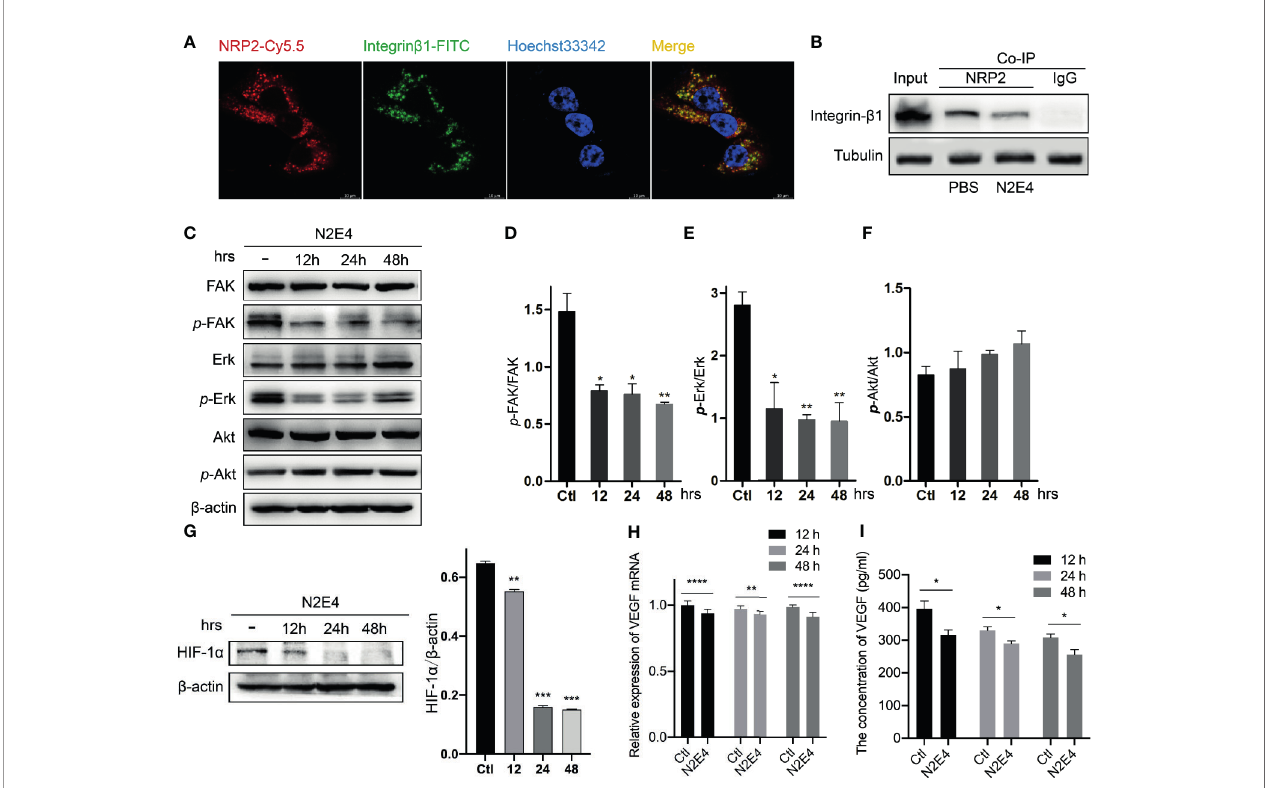
FIGURE 5 | Effect of N2E4 on selected signaling molecules in BxPC-3. (A) The co-localization of NRP2-Cy5.5 (red) with integrin b 1-FITC (green). (B) After BxPC-3 cells were pre-incubated with PBS (-) or N2E4 for 48 h, NRP2 and integrin b 1 proteins were immunoprecipitated with an anti ‐ NRP2 antibody and then immunoblotted using an anti ‐ integrin b 1 antibody. (C) After BxPC-3 cells were pre-incubated with N2E4 or PBS (as control) for 12, 24, or 48 h, western blotting was applied to determine levels of the total FAK, Erk1/2, and Akt, also the corresponding phosphorylated proteins. Densitometric analysis of phosphorylated protein levels was standardized against corresponding total protein levels: (D) FAK, (E) Erk1/2, and (F) Akt. (G) The test of HIF-1 a protein level by western blotting. (H) VEGF gene was detected by RT-PCR after cells were pre-incubated with N2E4 or PBS for 12, 24, or 48 h. (I) Autocrine protein VEGF was detected by ELISA. Bars are the means±SD, n=3. * P <0.05; ** P <0.01; *** P <0.001; **** P